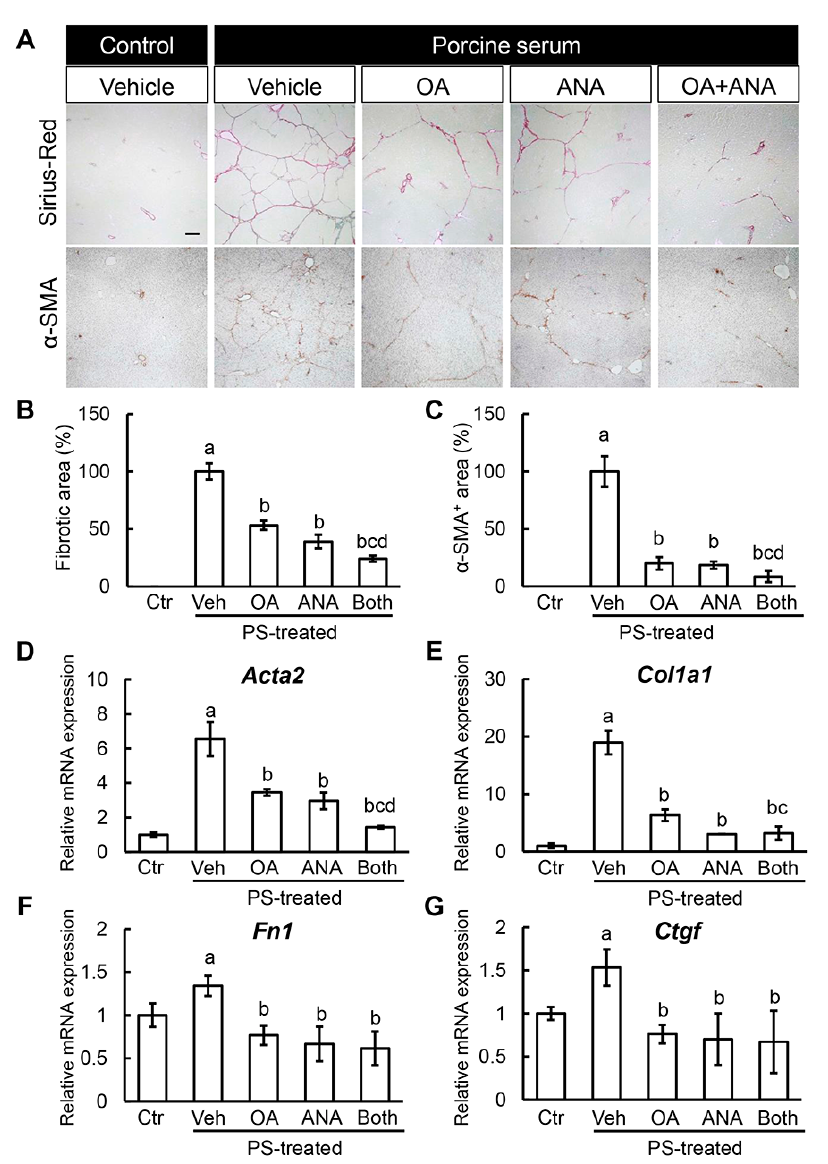
Figure 4. In vivo effects of oleanolic acid and anagliptin on liver fibrosis. ( A ) Representative microphotographs of liver sections stained with sirius red and α -SMA. Scale bar; 50 µ m. ( B , C ) Semi- quantitation of sirius red-stained fibrotic area (B: Ctr; 0 ± 0%, Veh; 100.0 ± 7.0%, OA; 53.2 ± 3.9%, ANA; 39.1 ± 5.9%, Both; 24.2 ± 2.6%), and α -SMA immune-positive area (C: Ctr; 0 ± 0%, Veh; 100.0 ± 13.3%,